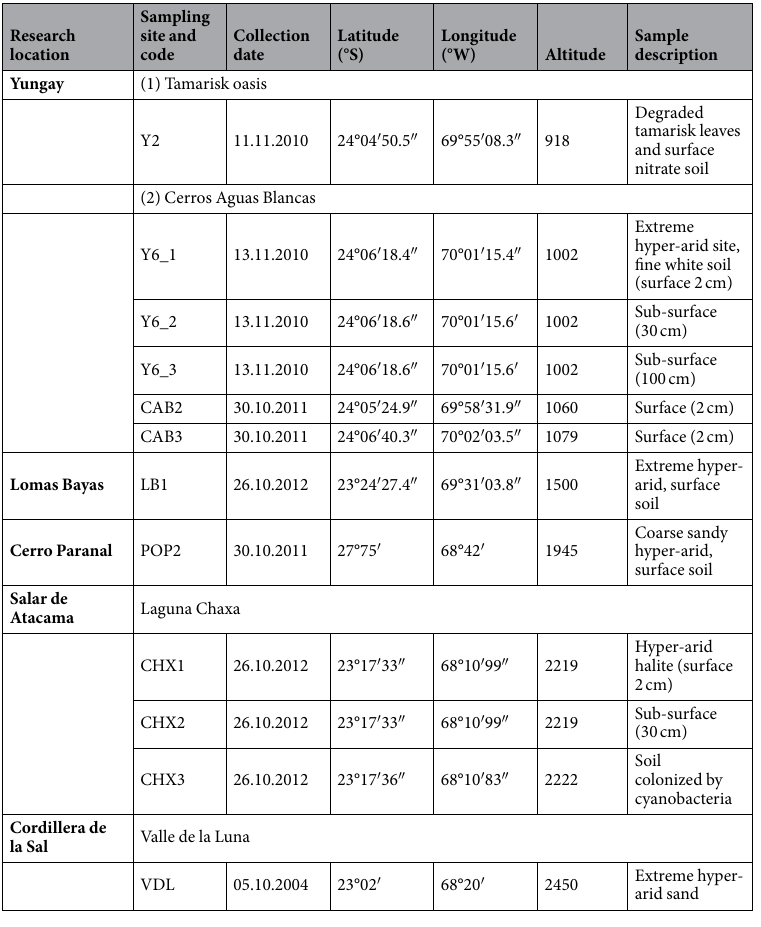
DNA extraction, PCR amplification and pyrosequencing. Total community DNA was extracted from all of the environmental samples using the proprietary UltraClean Soil DNA extraction kit (MoBIO Laboratories, Inc., USA) following the manufacturer’s protocol, and stored at − 20 °C. Soil extractions were made in a lami- nar flow chamber using sterilized equipment in order to avoid contamination. The quality of community DNA preparations was checked by agarose gel electrophoresis and the sizes of the DNA fragments were compared with a molecular size marker (Gene Ruler TM , MBI Fermentas, Vilnius, Lithuania). Actinobacterial specific regions in community DNA preparations were amplified using the primers Com2xf (5 ′ -AAA CTC AAA GGA ATT GAC GG-3 ′ ) and Ac1186r (5 ′ -CTT CCT CCG AGT TGA CCC-3 ′ ) 56 . Unique, sample-specific barcodes (10 bp) were attached to the 5 ′ end of the forward primer. Four replicates were con- structed from each of the environmental samples, the latter were assigned individual barcodes. PCR was made in 25 μ l reaction mixtures containing 1 μ l DNA template, 1x buffer (10x buffer: 160 mM